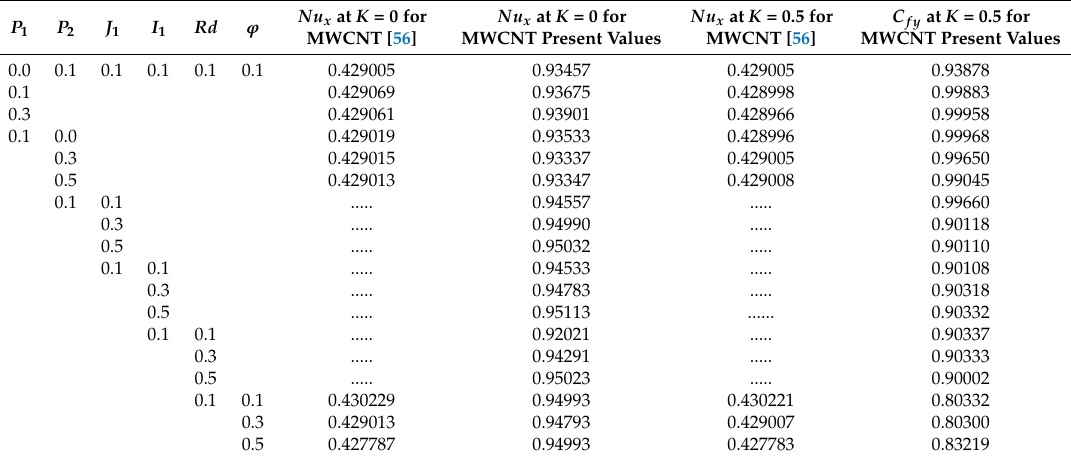
Table 8. Variation in Nu x (the Nusselt numbers) for MWCNTs together with strong and weak concentrations K = 0 and K = 0.5 and the comparison with previous results for E r = 0.2, δ = 0.1, and Re = 0.3.